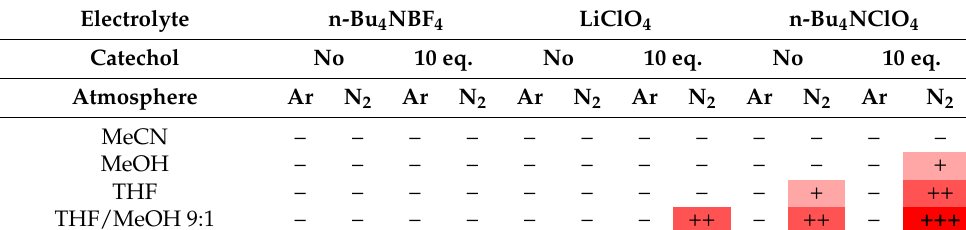
Table 1. Results of qualitative tests of 24 h electrocatalytic ammonia generation at − 2.3 V under N 2 (with control experiment under Ar) using 10 mL of a working solution containing 2 mM Cp 2 TiCl 2 catalyst in various in solvents (MeOH, THF, MeCN, THF/MeOH), 0.1 M of electrolyte (n-Bu 4 NBF 4 , LiClO 4 , n-Bu 4 NClO 4 ) and optionally 20 mM (10 equivalents) of catechol